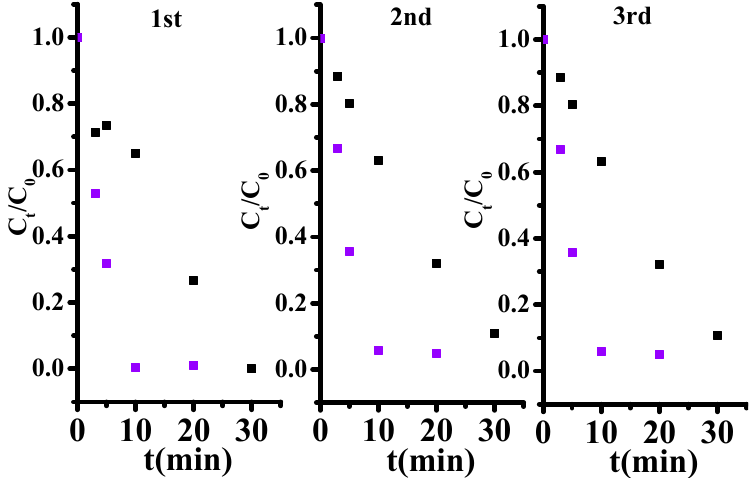
Figure 6. The usability of L-MIL-101(Fe)/TiO 2 within three recycles. Black dot and purple.dot represent the dynamic of Cr(VI) reduction and MC-LR degradation respectively. [Cr(VI)] 0 = 2 ppm, [MC ‐ LR] 0 = 1.5 ppm, Catalysts dose = 0.05 g/L;